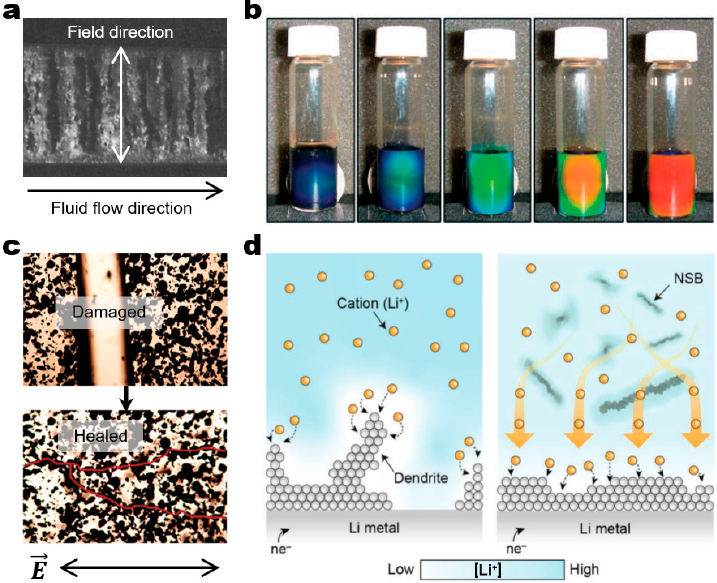
Figure 11. Applications of fi eld-driven dynamic architectures for smart functional devices. ( a ) an electrorheological fl uid illustrating the fi eld-driven structuring of fi brous structures from 60 µm spherical silica particles. The formed fi brous structures e ff ectively block the fl uid fl ow, resulting in apparent viscosity. Here, the fl uid fl ow direction is orthogonal to the alignment direction of the fi brous structures. Reproduced with permission [79]. Copyright 1989, Elsevier. ( b ) Magnetic fi eld-responsive photonic crystals of superparamagnetic colloidal nanocrystal clusters, displaying di ff erent colors depending on the fi eld amplitude. The distance between the sample and a MdFeB magnet determines the fi eld amplitude and modulate the la tt ice spacing of the photonic crystals. Reproduced with permission [83]. Copyright 2007, Wiley. ( c ) Electric fi eld-driven self-healing of conductive microwires of eutectic gallium indium (EGaIn) microdroplets. (top) The mechanically damaged circuit. (bo tt om) The self-healed circuit via DEP assembly of EGaIn microdroplets upon the